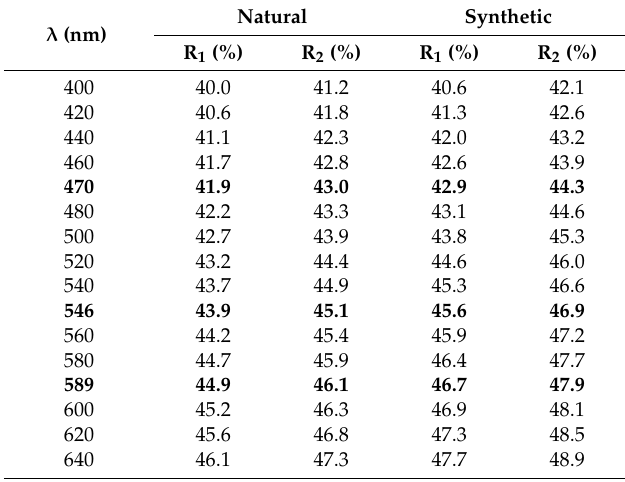
Table 1. Reflectance data for natural and synthetic thalhammerite.